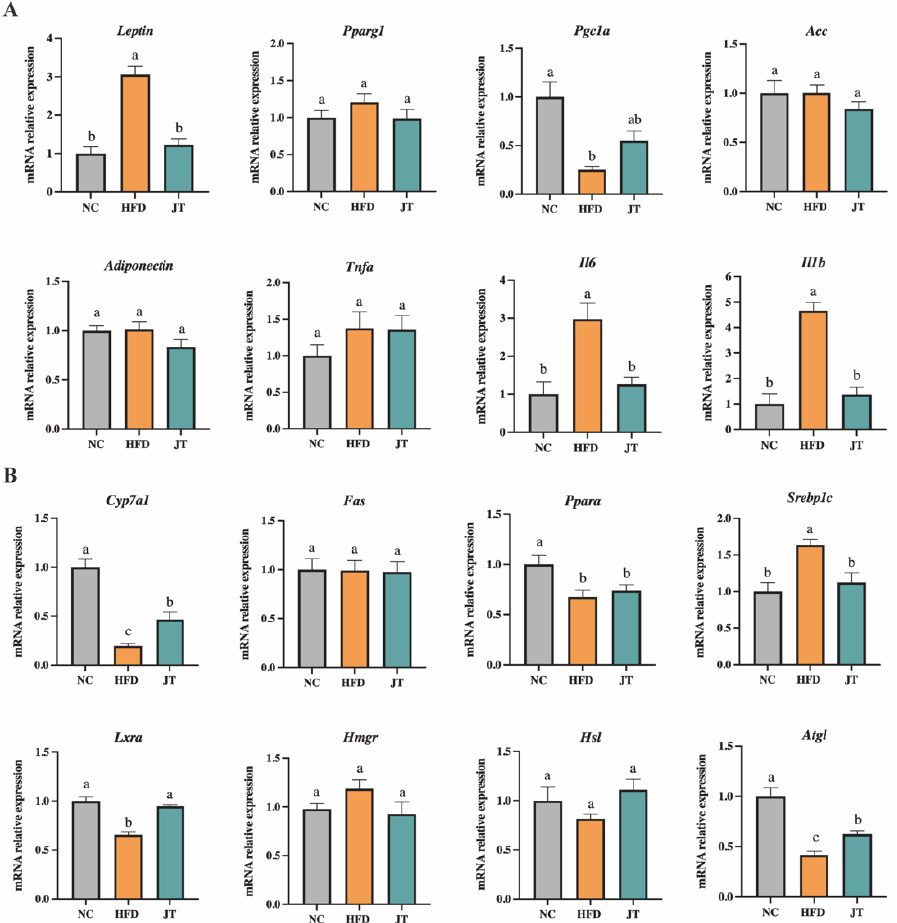
Figure 4. CB-JT regulated HFD-induced abnormal expression of lipid metabolism-related genes. ( A ) Relative mRNA expression in the epididymal adipose tissue. ( B ) Relative mRNA expression in the liver tissue. Expression levels were normalized to β -ACTIN and expressed as relative fold changes in comparison with the NC group (mean ± SEM). NC: normal-chow group, HFD: high-fat diet group, JT: jasmine tea group. The mean value with different letters indicates significant differences ( p < 0.05).